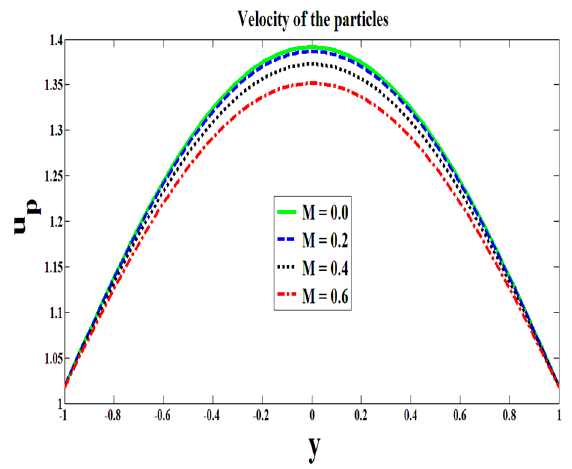
Figure 3. Effects of magnetic fields on the particles.